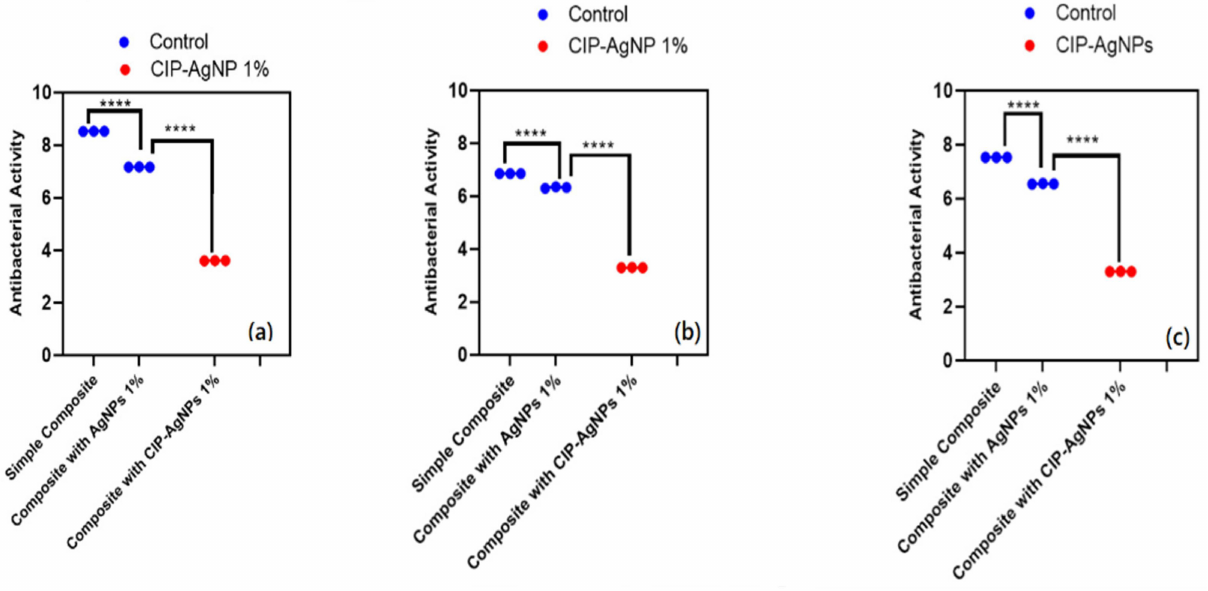
Figure 8. CFU/mL of ( a ) E. faecalis , ( b ) S. mutans , ( c ) Saliva microcosm model, antibacterial effect of modified composite resin discs ( p < 0.05). **** p < 0.0001